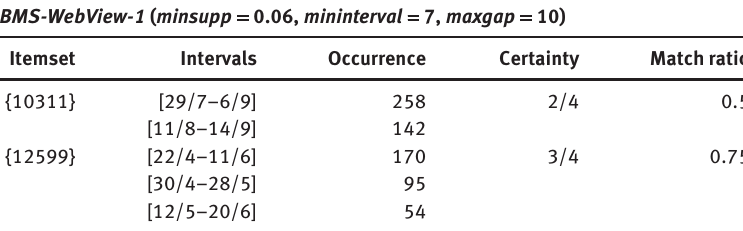
Table 8. Selected Yearly Periodic Itemsets of Size One (for BMS-WebView-1 ).